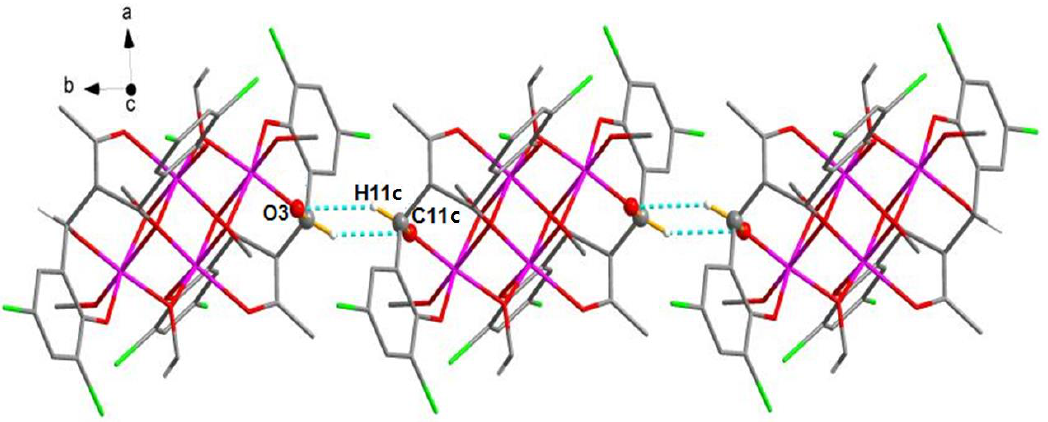
Figure 6. Part of 1D supramolecular structure containing C19b–H19Ab···O5 hydrogen bond interactions along a axis of the Mn III complex 1 (symmetry code: b = 2 − x, 1 − y, 1 − z).